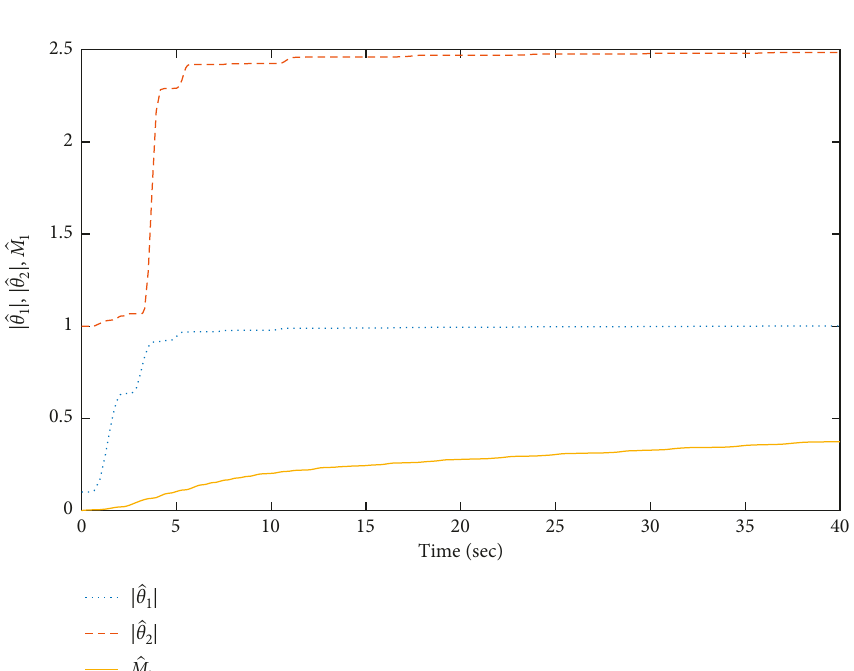
Figure 3: Adaptive parameters | 􏽢 θ